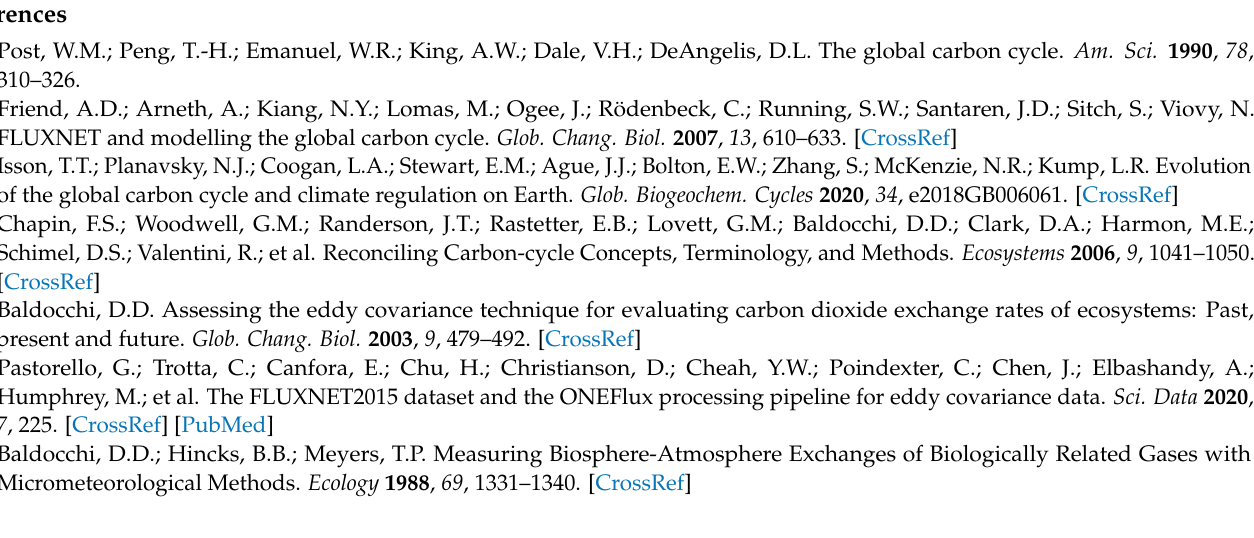
Figure S3 Mutation detection performed on the evaluation results of Random Forest corresponding to the Figure 4e–h by the BG segmentation algorithm. The x axis and y axis values are the same as in Figure 4e–h. The black vertical dash lines represent mutation points, Figure S4 Correlation between training samples and training duration for (a) RF and (b)